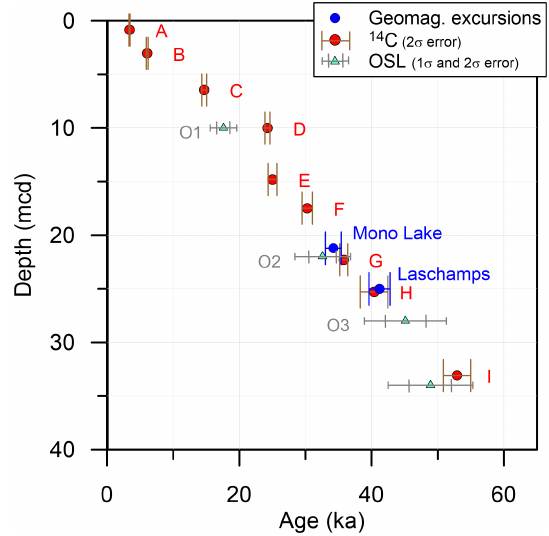
Figure 2. OSL and AMS 14 C dating results of core composite Co1401 and locations of Laschamps and Mono Lake excursions. Ages and age uncertainties of the geomagnetic excursions are taken from Laj et al.